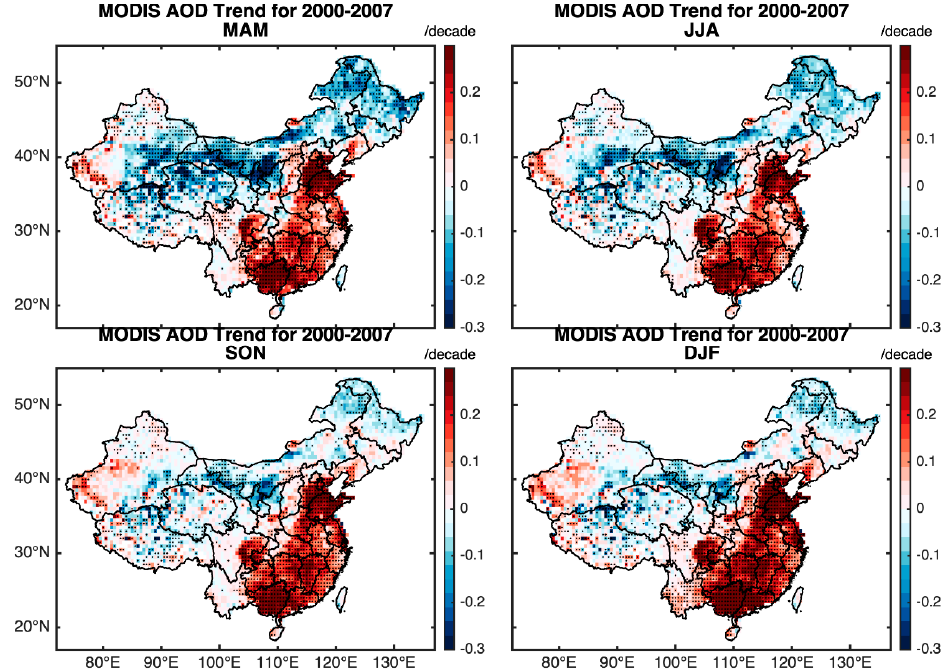
Figure 4. MODIS Terra AOD trends calculated during the 2000–2007 period for the four seasons: Spring—March, April, May (MAM); Summer—June, July, August (JJA); Fall—September, October, November (SON); Winter—December, January, February (DJF). The trends were calculated as the Sen’s slope and tested using the Mann–Kendall test. Trends with significance level >95% are marked with black dots.